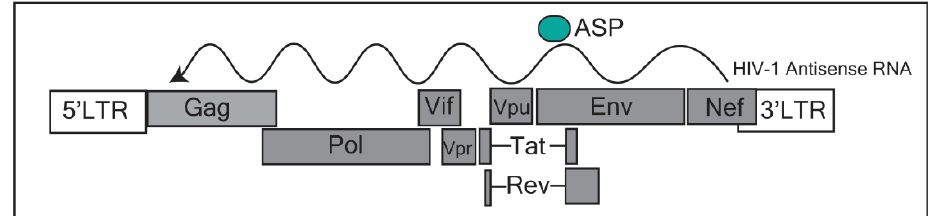
Figure 1. Annotation of the human immunodeficiency virus (HIV-1) genome. The HIV-1 antisense RNA transcriptional start site occurs in the Nef region. The putative protein, the antisense protein (ASP), is translated near the 5′ region of the antisense transcript, corresponding to the Env region in the HIV-1 genome. This figure was adapted from Saayman et al. (2014) [10] and Cassan et al. (2016) [37].